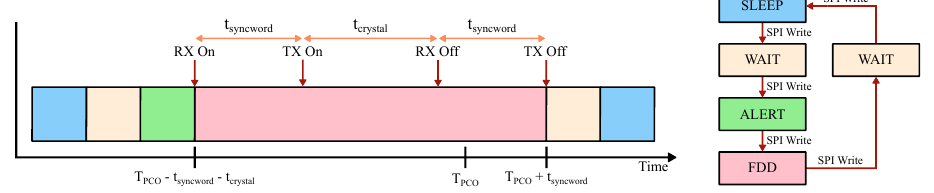
Figure 11. Optimized state transition diagram of the radio. TX can lag RX by t syncword . RX must be enabled before the natural PCO reset to account for the reference crystal uncertainty. Reference crystal quality and syncword duration set the limit on how the system components can be duty-cycled. RX and TX latencies are omitted from the diagram for visual